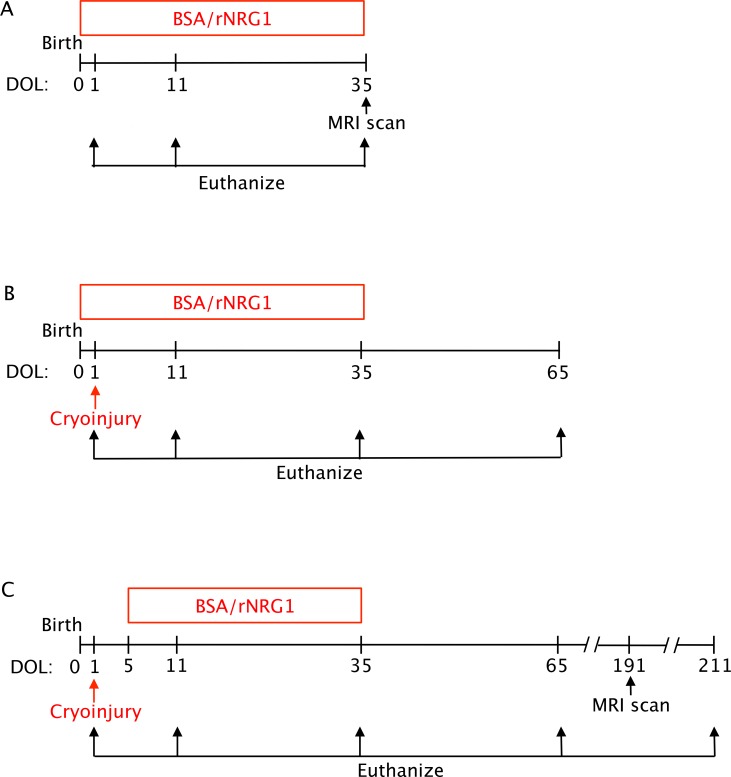
Diagrams of study design.Daily injections of vehicle (BSA) and rNRG1 were begun on the day of life 0 (A, B) and day of life 5 (C) and are indicated with red boxes. Cryoinjury was performed on day of life 1 (P1, B, C). DOL, day of life.